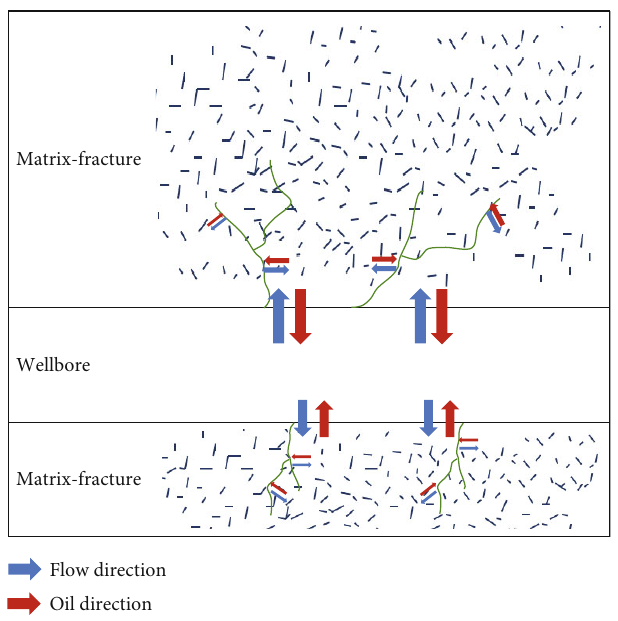
Figure 14: Imbibition mechanism of hydraulic